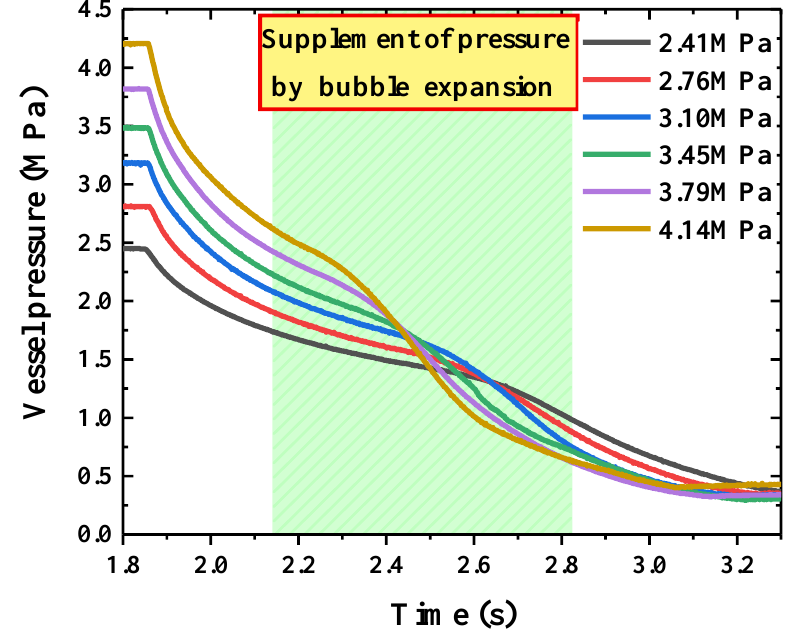
Figure 6. The vessel pressure of HFC-125 agent under various release pressures.